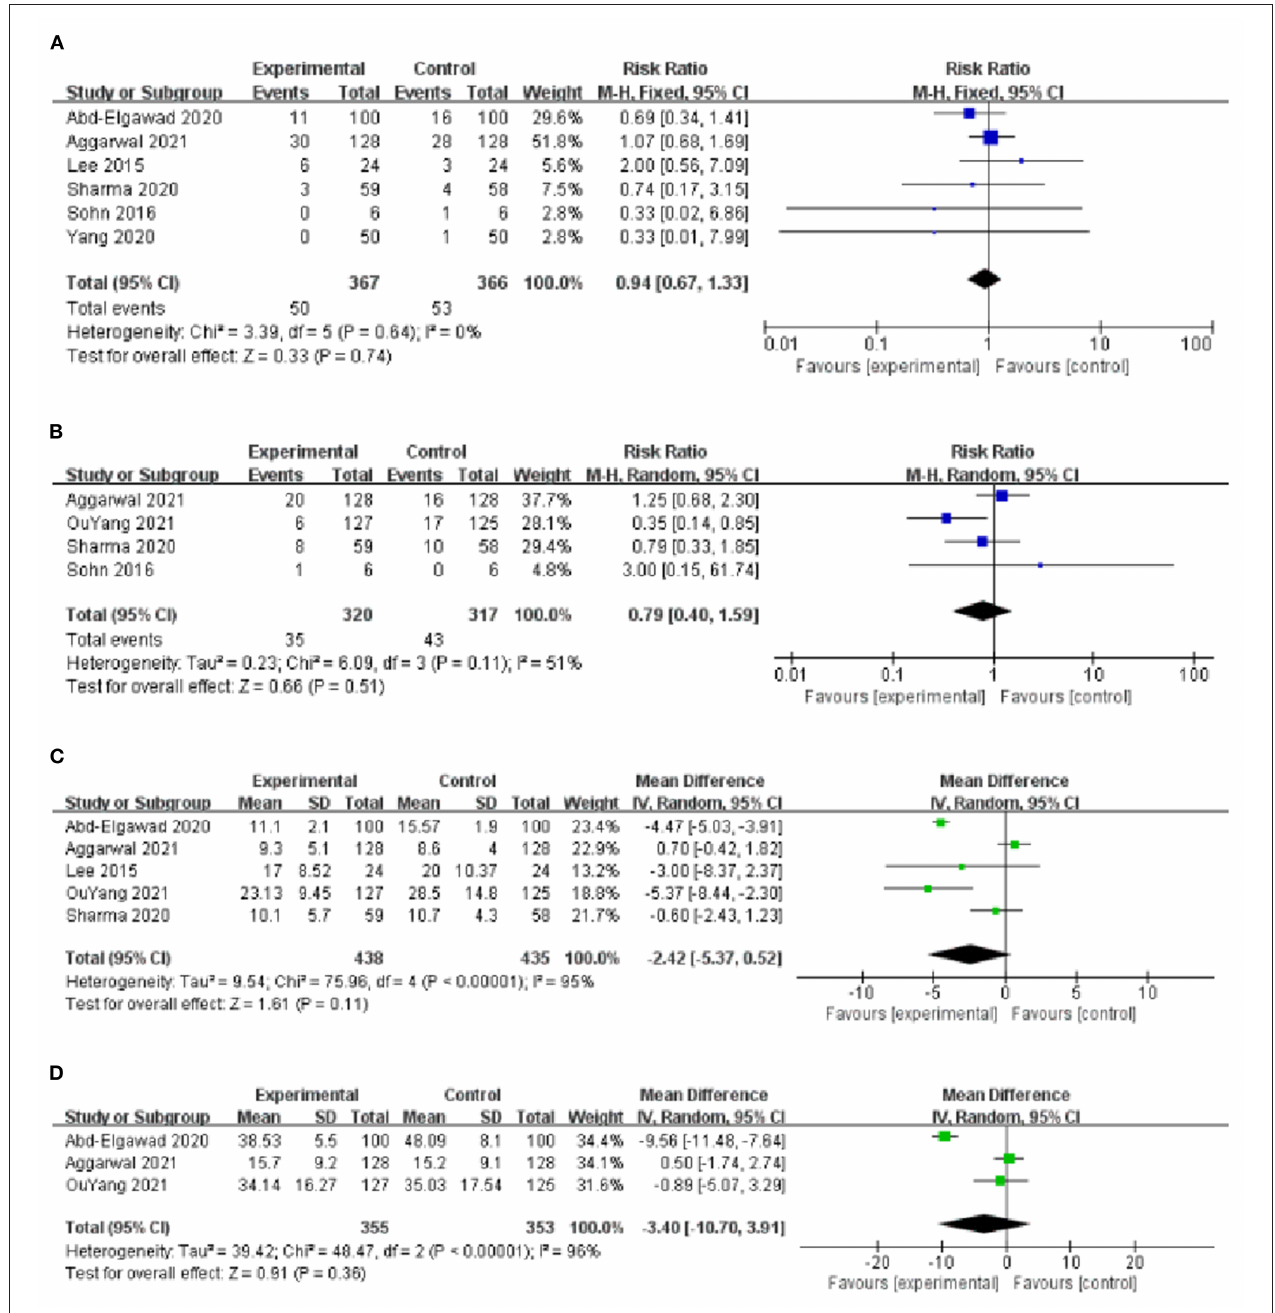
FIGURE 5 | (A) Forest plot of the mortality during hospitalization. (B) Forest plot of the late-onset sepsis. (C) Forest plot of the time of full intestinal feeding. (D) Forest plot of the time of full oral feeding.